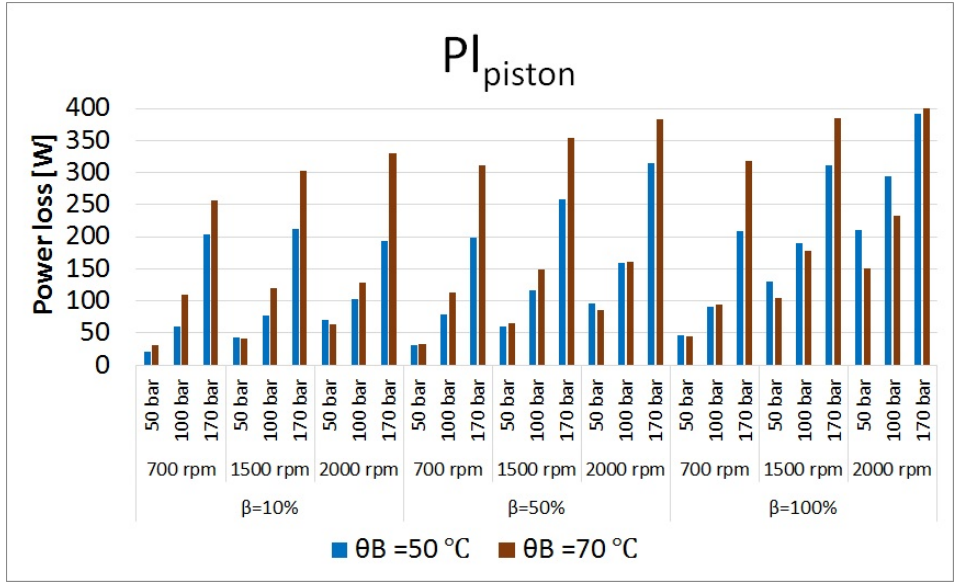
Figure 23. Compression power losses at different operating conditions.